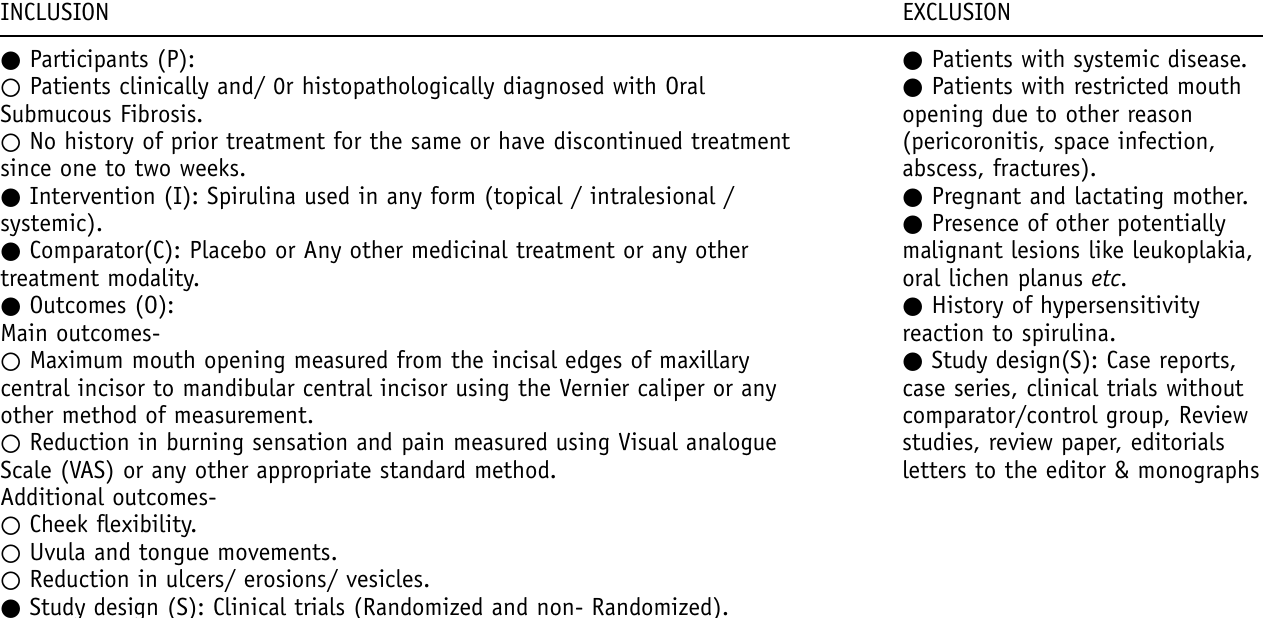
Table I. Eligibility criteria of included studies according to Participants, Intervention, Comparator and Outcomes (PICO).